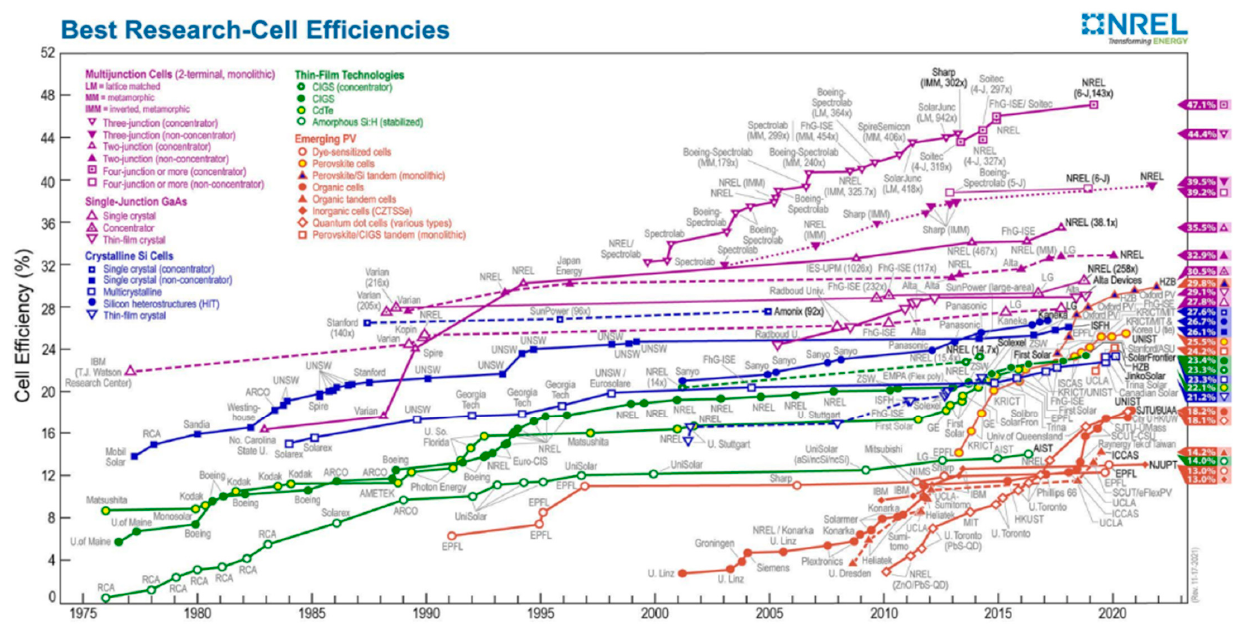
Figure 2. Best solar cell efficiencies, taken from the National Renewable Energy Laboratory (NREL) [35].